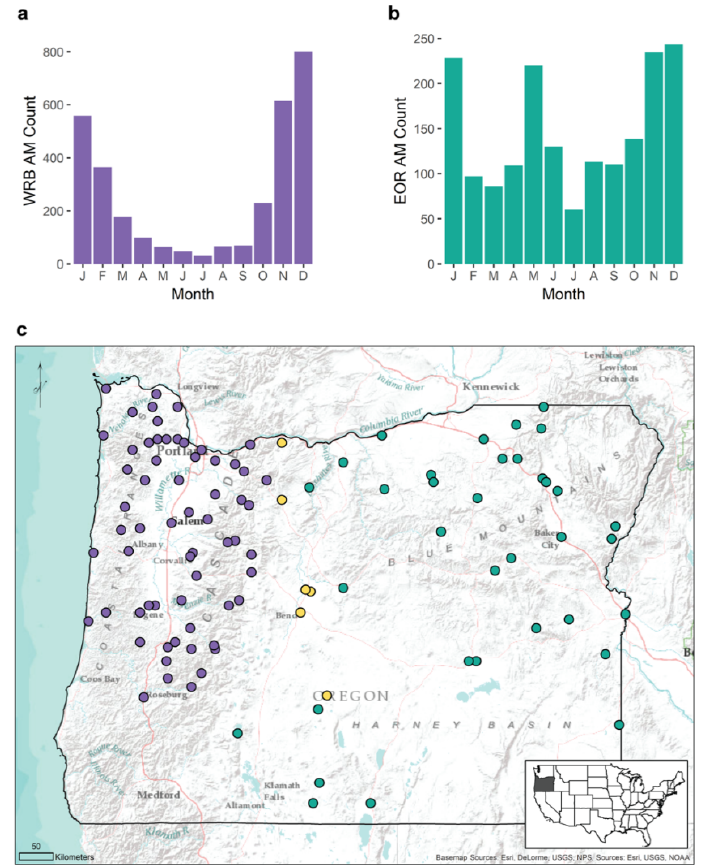
Figure 1. Study regions with location reference numbers, and annual maxima (AM) climatology where ( a ) is the count of AM events by month for the Willamette River Basin (WRB) and ( b ) is the count of AM events by month for the eastern Oregon (EOR) study region. Within the study region map ( c ), the purple markers indicate locations included exclusively within the WRB, while green markers indicate those within the EOR. The yellow markers are the locations that were included within both study regions. Basemap Source: ESRI [44].